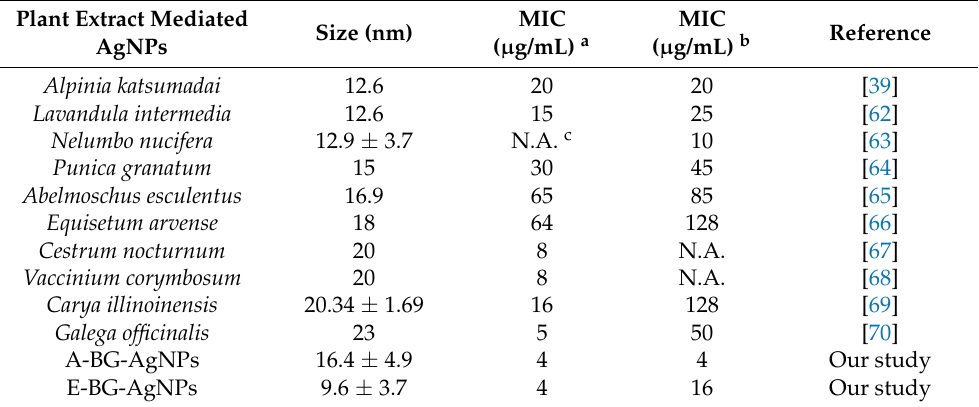
Table 2. Comparison of MIC against E. coli , and S. aureus by AgNPs synthesized using different plant